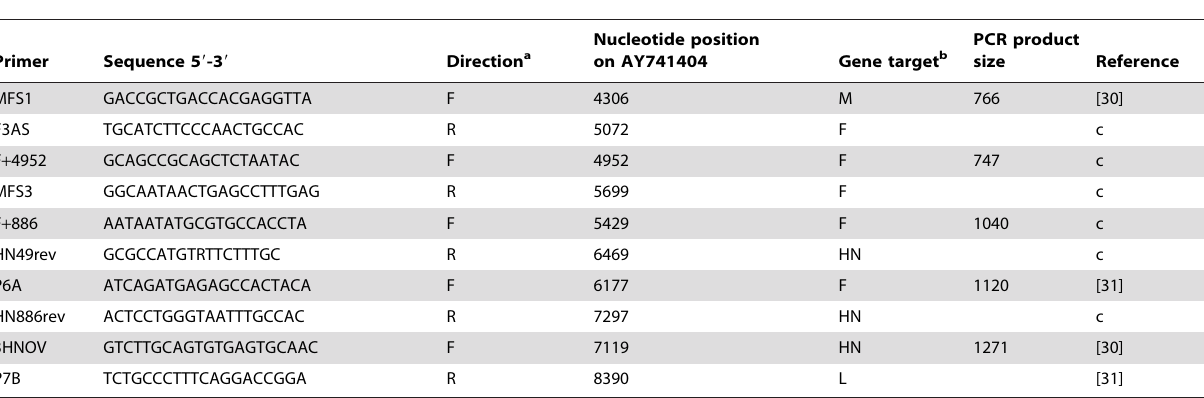
Table 1. Primers used for complete sequencing of the F and HN